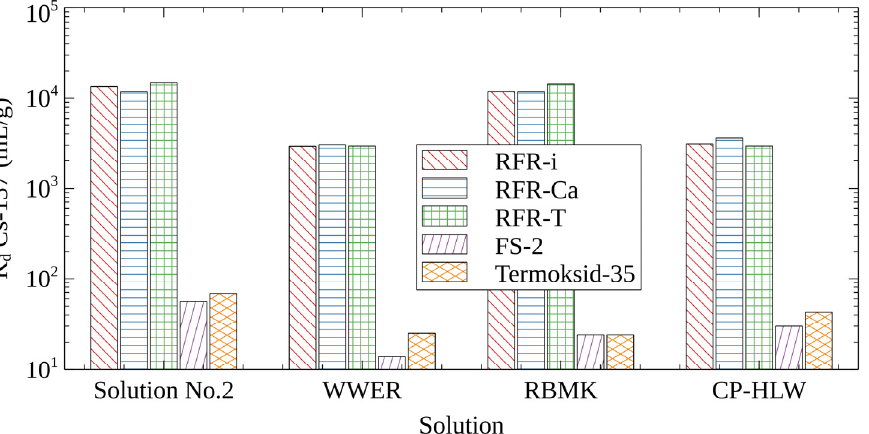
Figure 1. Cs-137 distribution coefficients on selective sorbents in solutions simulating different types of LRW.